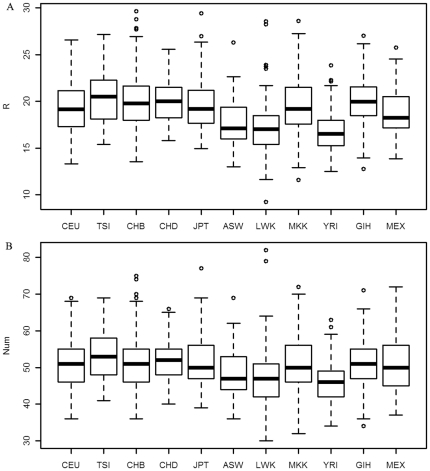
The overall genetic risk on all screened SNPs in catabolic process.R (subplot A) is the sum of harmful probabilities on all screened SNPs, and Num (subplot B) is the total number of mutations on all screened SNPs.